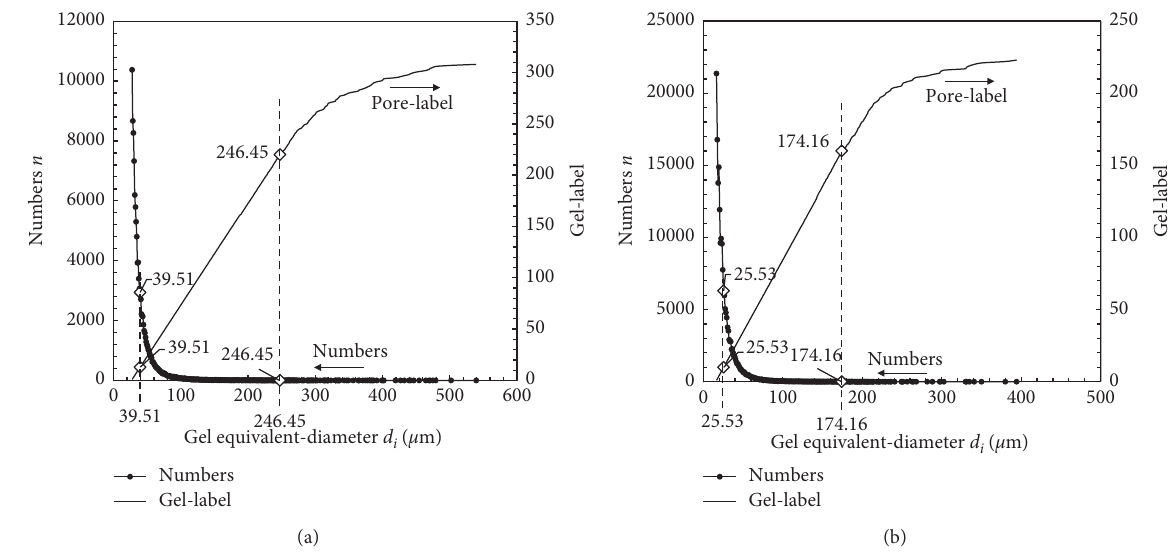
Figure 25: Quantity and continuity distribution of gel-phase of NCG concretion by 3D-XRM. (a) W1 N. (b) W4